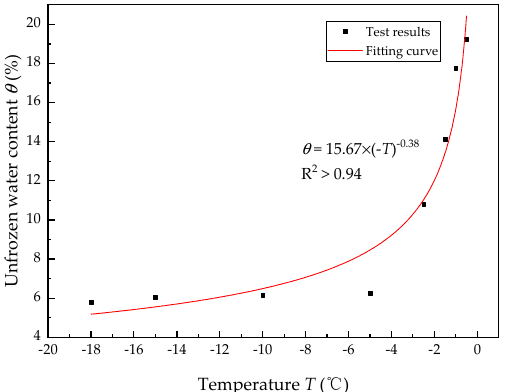
Figure 3. Relationship between unfrozen water content and temperature.